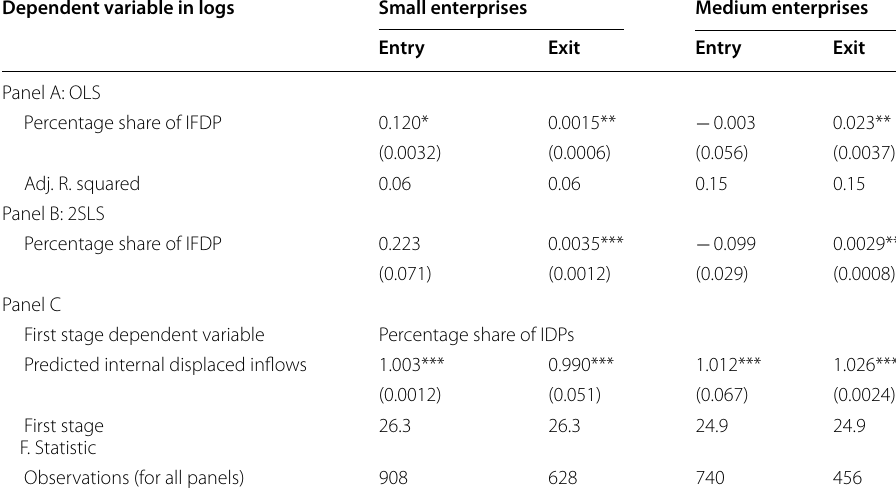
Each coefficient corresponds to a separate regression and all panels include controls for zone and year fixed effects. The standard errors clustered at the zonal level are shown in the parenthesis. *** Represents the significant level at 1%, ** represents significant at 5% and * represents significance at